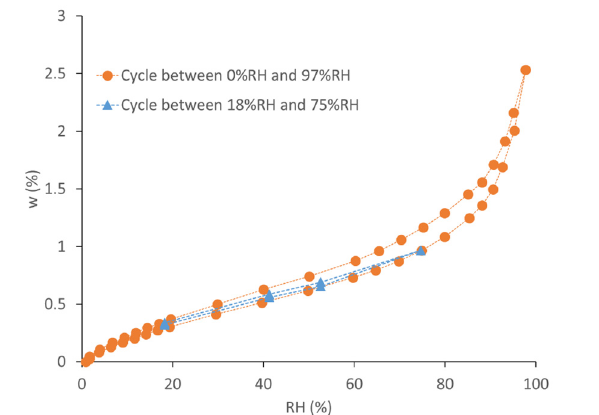
Figure 1. Influence of the amplitude of the sorption‐desorption cycle on its hysteresis. The test is made with the DVS method on the earth plaster referenced as P1 in